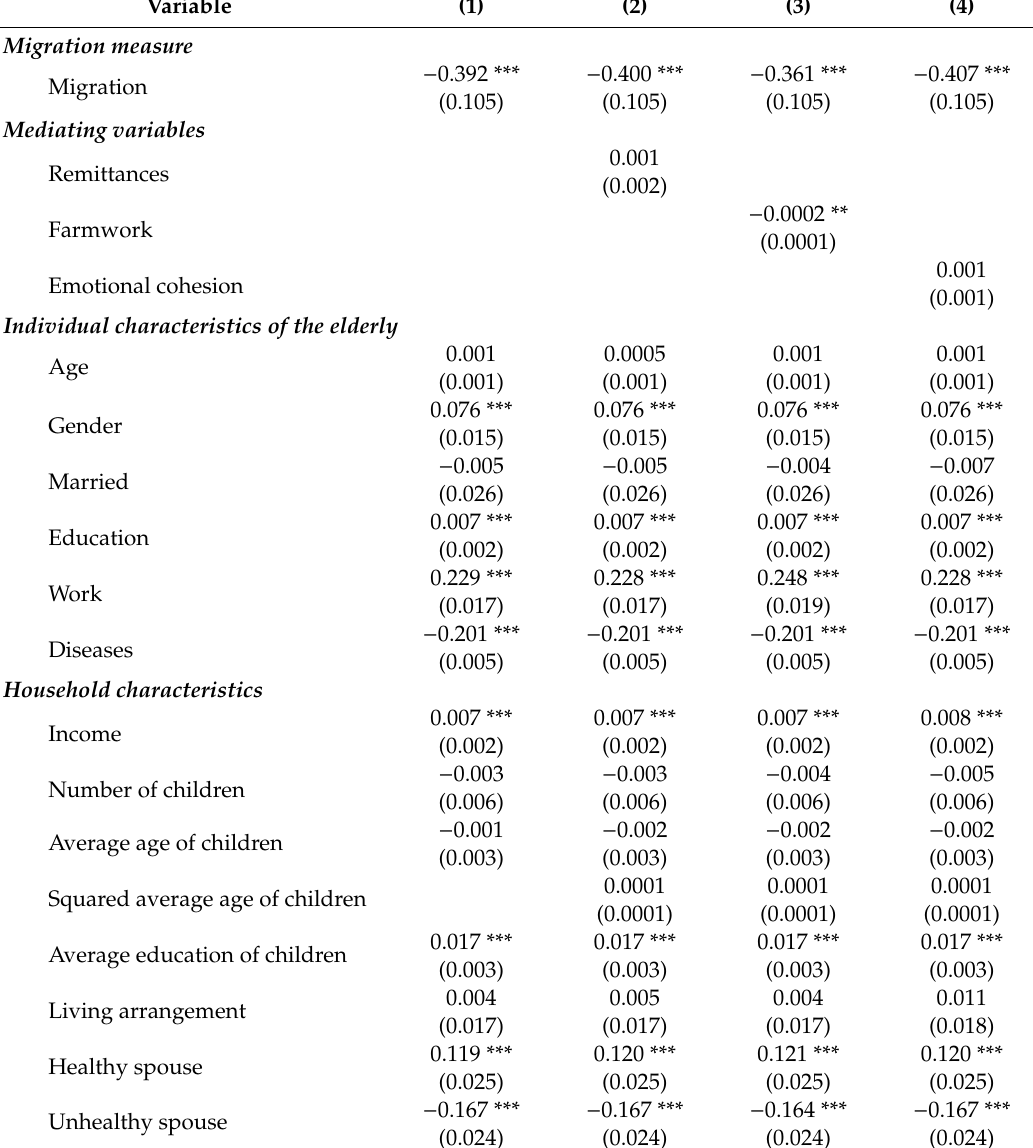
Table 5. The health e ff ect of child migration and inter-generational support (SRH).